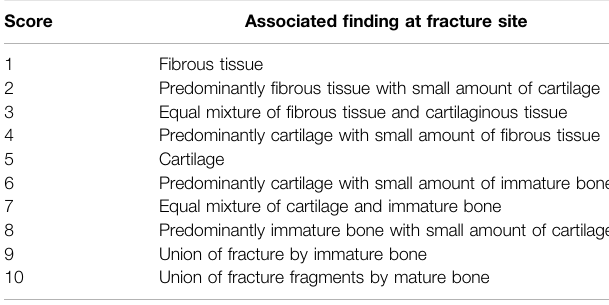
TABLE 1 | The numerical scoring scheme used for the histologic evaluation of fracture healing according to Huo et al.